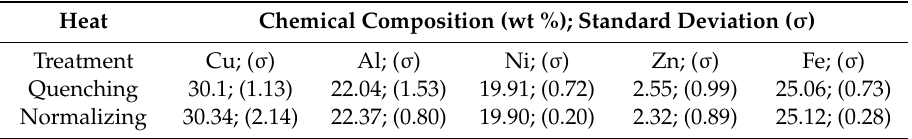
Table 2. Chemical composition of intermetallic compounds as a function of heat treatment.